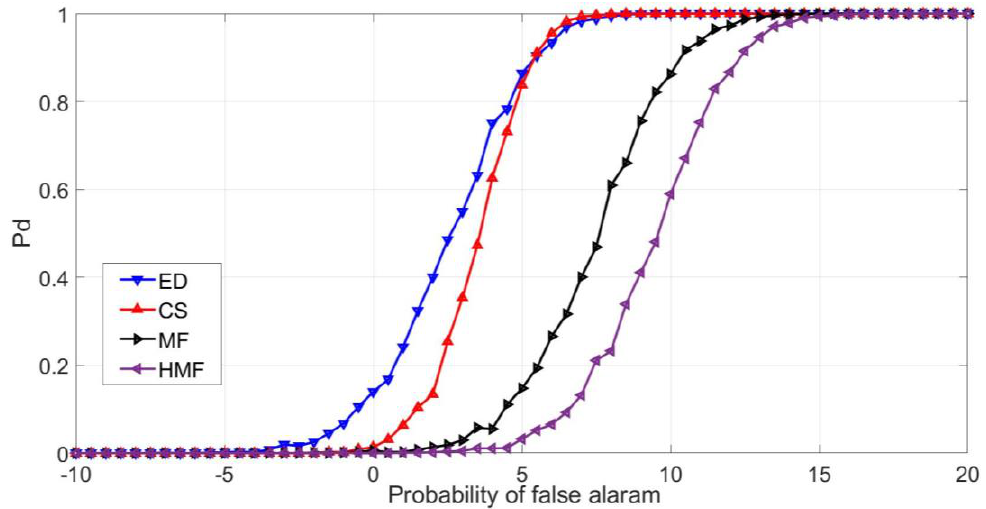
Figure 13. Pd and Pfa for the Rician channel.